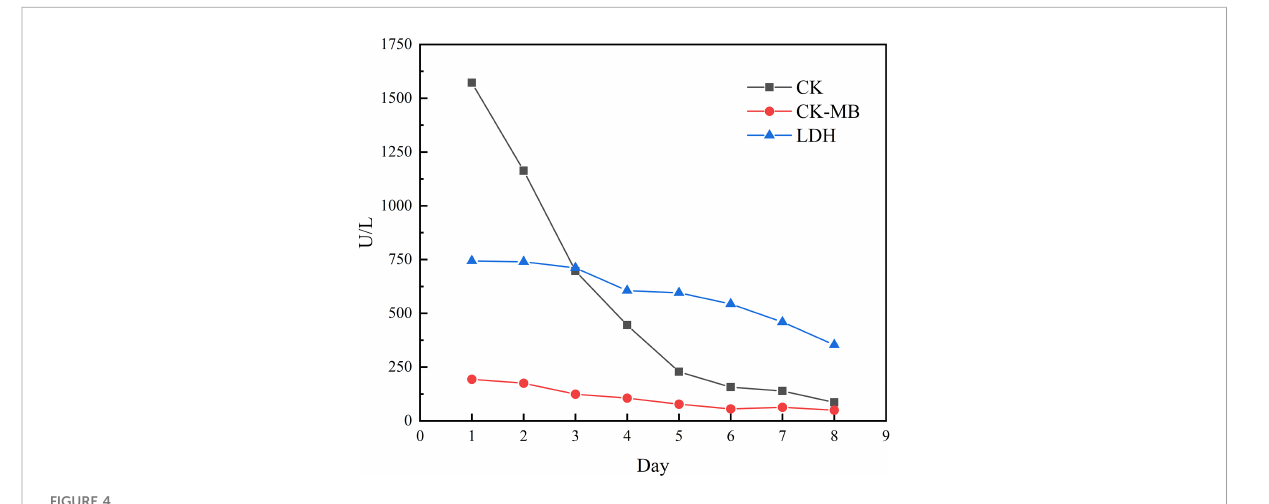
FIGURE 4 Changes of some indicators (2021/03/03-2021/03/10).